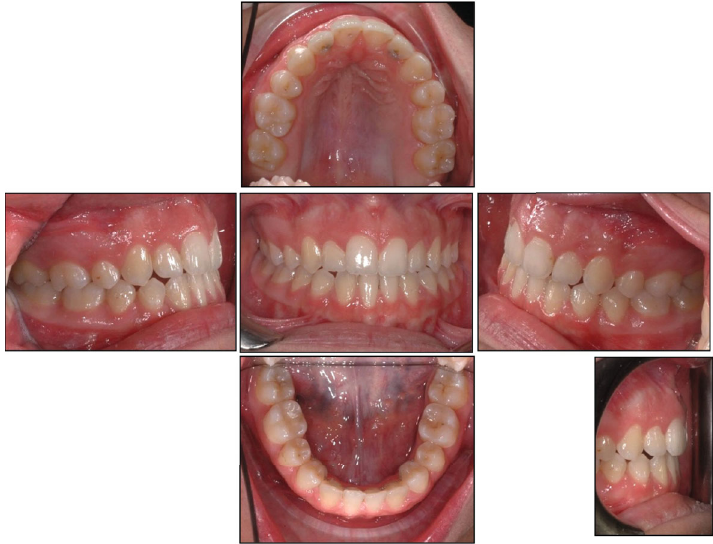
Figure 11: Intraoral photographs two years after orthodontic